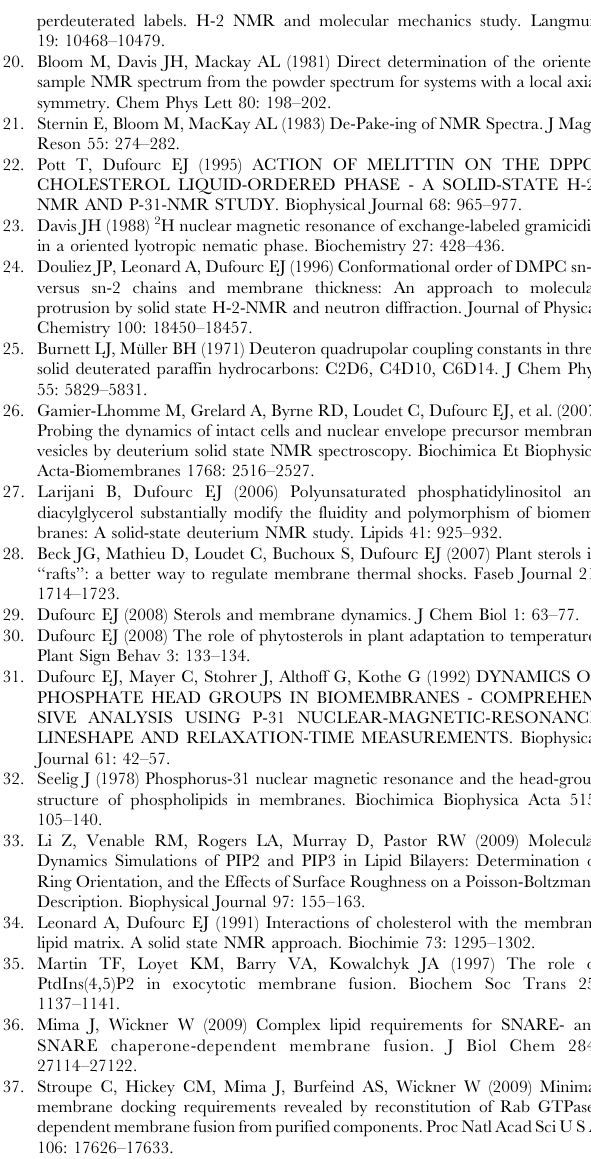
Figure S2 Core fluidity of ‘‘MV2-like’’ model mem- branes. Representative deuterium wide-line NMR spectra of pure POPC-2H (left column) and with a MV2 composition: POPC/Chol/PtdIns/PtdEth/PtdSer (30/20/20/25/5). Temper- atures are indicated on the spectra. Other parameters are as in main text. Figure S3 Order Parameter of end chain segments, ‘‘NER-like’’-membranes. Thermal variation of the C16- 2 H 3 (k= 16) quadrupolar splittings of POPC/Chol/PtdIns (28/42/30) and POPC/Chol/PtdIns/PtdInsP (28/42/23/7), panel A;